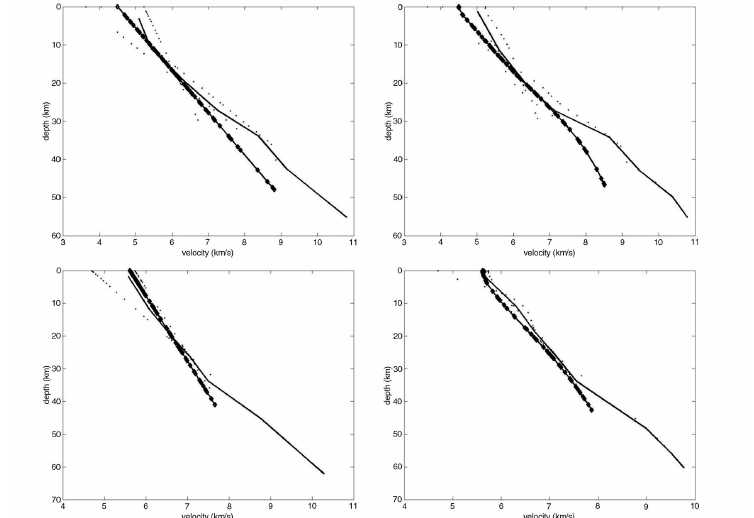
Fig. 8. Average velocity models calculated for the Southern Sicilian area (on the top) and for the part of the Central-Apennines crossed by profile 1 of the Toscana78 project (on the bottom). The graphs on the left side are relative to the constant gradient model, those on the right side are relative to the variable gradient model. The points represent the velocity functions relative to each of the profiles; the solid line with diamonds represents the 1D model obtained inverting the average travel time-offset curve of the area; the solid line is the average of the velocity-depth functions relative to each profile.